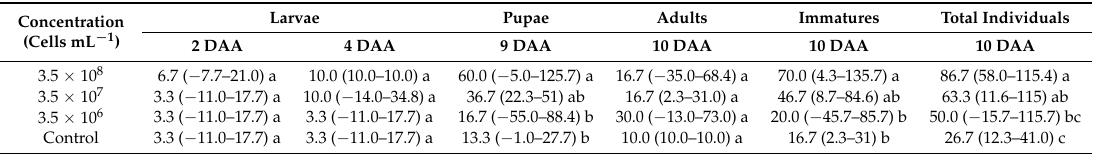
Table 3. Mortality of Drosophila suzukii larvae, pupae and adults following dipping the larvae in Photorhabdus luminescens at different